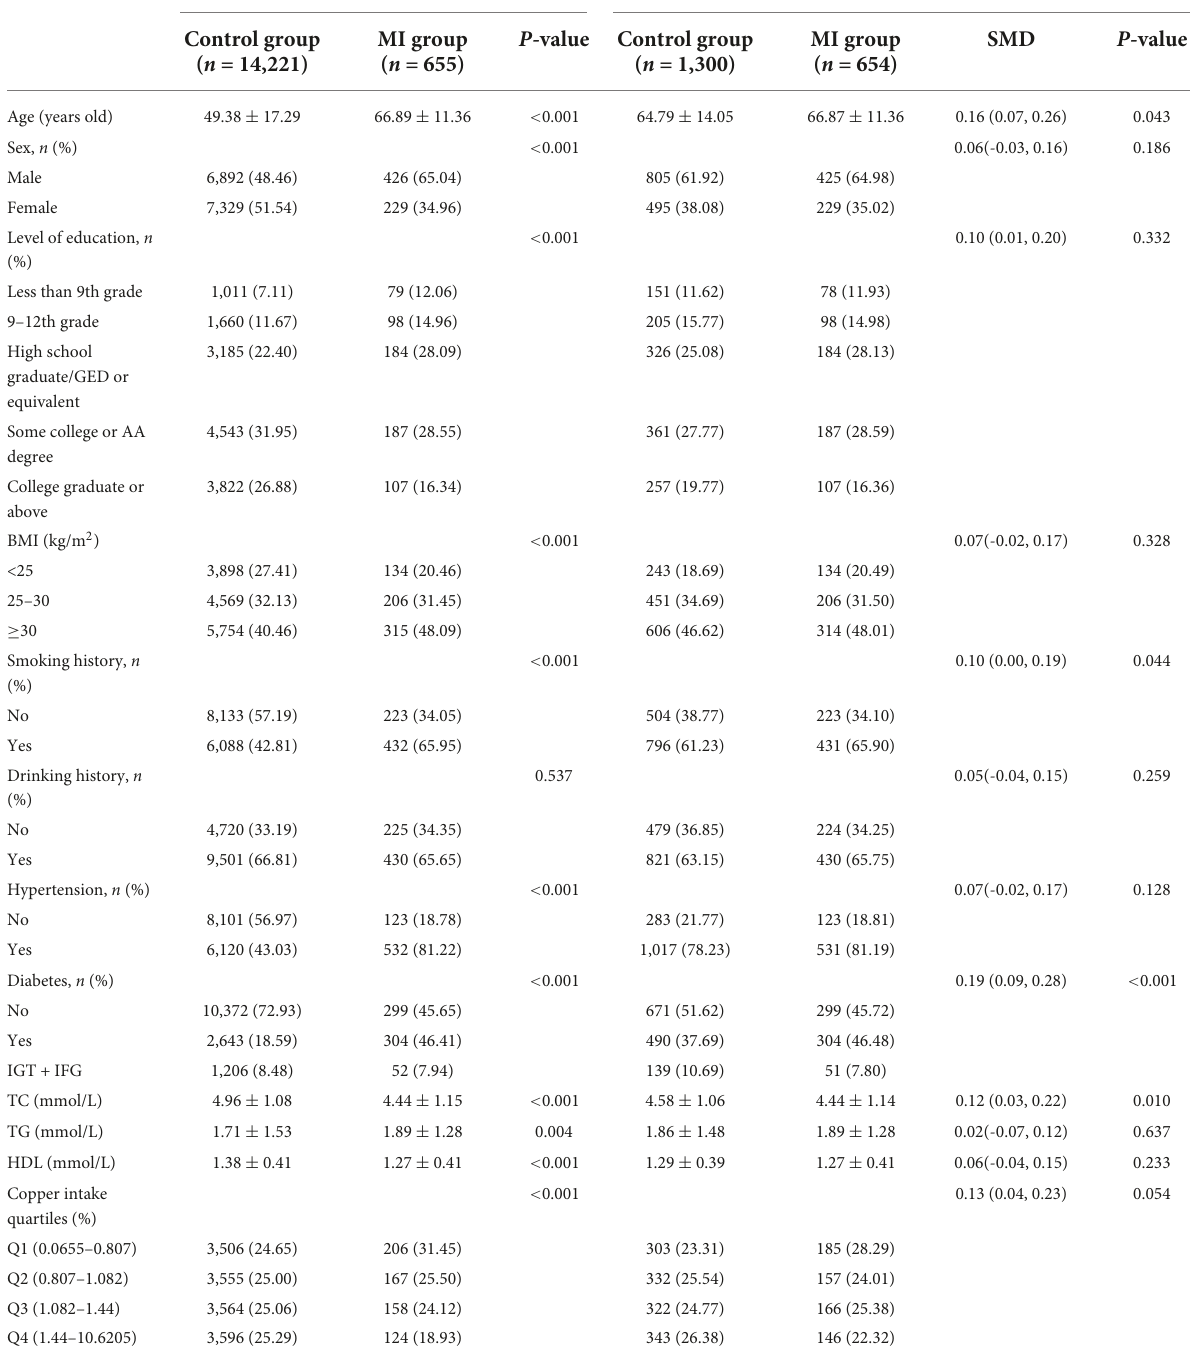
TABLE 2 Characteristics of participants before and after matching by myocardial